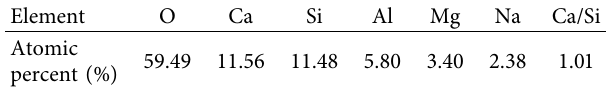
Table 3: AASC conclusions of atomic ratio.